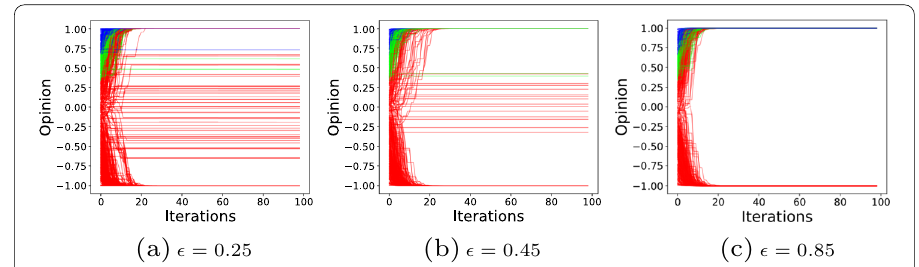
Fig. 8 Opinion evolution on LFR network with WHK G varying ǫ with configuration A. There is not a polarization into two distinct groups, so the community structure inhibits the polarization; there is not a polarization into two distinct